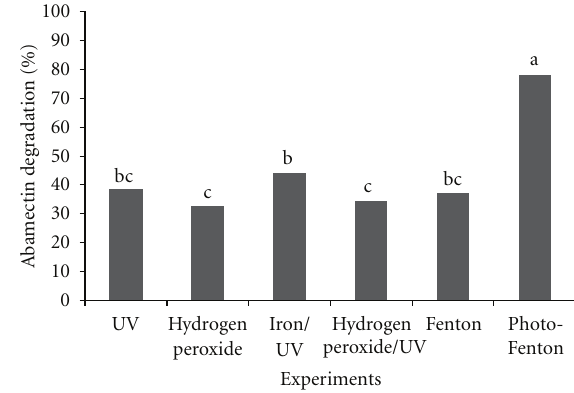
Figure 3: Multiple comparison tests for the di ff erent processes applied to abamectin removal. The same letters above the means for the di ff erent procedures indicates that statistically there were no di ff erences between the procedures, using Tukey’s test at a 5% level of significance. Conditions: [H 2 O 2 ] = 6.0 mmolL − 1 ; [Fe 3+ ] = 0.5mmolL − 1 ; abamectin = 9.0 mgL − 1 ; λ = 365 nm; initial pH =